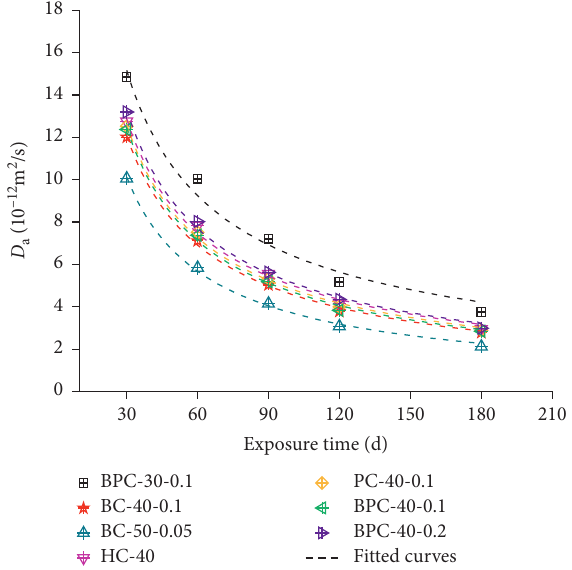
Figure 11: Relationship between apparent chloride diffusion co- efficient and exposure